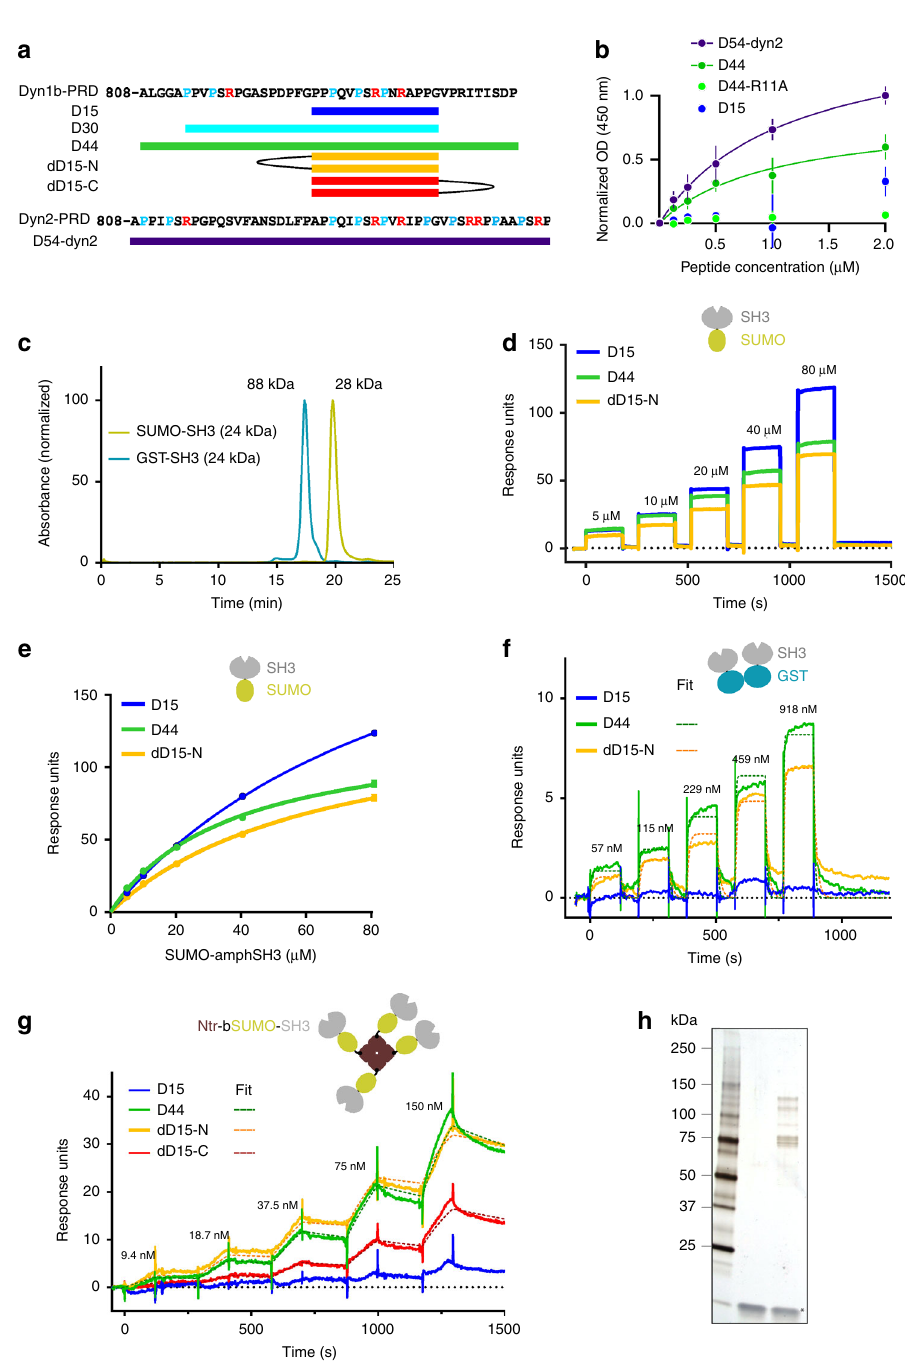
Fig. 4 Binding of mono- and multimeric SH3 domains to D15-based peptides. a Scheme of the peptides used in this study, based on dynamin1b (top) and dynamin2 (bottom) PRDs. b ELISA to evaluate the respective binding properties of biotinylated peptides to surface-bound SUMO-SH3 domains (K D = 1.12 and 1.01 µ M for D54-dyn2 and D44 respectively, the other peptides were not fi tted). Each data point represents the average of two independent experiments with two technical replicates each. c Retention times of SUMO-SH3 and GST-SH3 measured by size exclusion chromatography. The theoretical molecular weights are indicated. For SUMO-SH3 the elution peak corresponds to 28 kDa, close to the expected monomer, whereas for GST- SH3 it corresponds to 88 kDa, close to the expected size of a dimer. d Representative sensorgrams of SUMO-SH3 binding at indicated concentrations to immobilized peptides. Note the fast on and off rates for all peptides consistent with weak and transient interactions. e Steady-state K D s calculated from the data in ( d ) (three replicate experiments): 102 ± 2 µ M (D15), 37 ± 2 µ M (D44), 66 ± 3 µ M (dD15-N). f Representative sensorgrams of GST-SH3 binding at indicated concentrations to immobilized peptides. The scheme on top (GST in blue, SH3 in grey) indicates that this protein likely forms dimers (see b ). Dotted lines represent fi ts with estimated K D s of 572 nM (D44) and 509 nM (dD15-N). g Representative sensorgrams of Ntr-bSUMO-SH3 binding at indicated concentrations to immobilized peptides. The scheme on top shows the multimeric complex formed by bSUMO-SH3 bound to tetrameric neutravidin (brown). Dotted lines represent fi ts with estimated K D s of 17 nM (D44), 4.5 nM (dD15-N) and 34 nM (dD15-C). Note the change in kinetics (slower off rates) for D44 and the multimeric peptides (dD15-N and dD15-C). h Silver stain of rat brain lysate pull-down with no peptide (middle) or biotinylated dD15-N (right) NATURE COMMUNICATIONS| (2019) 10:4462